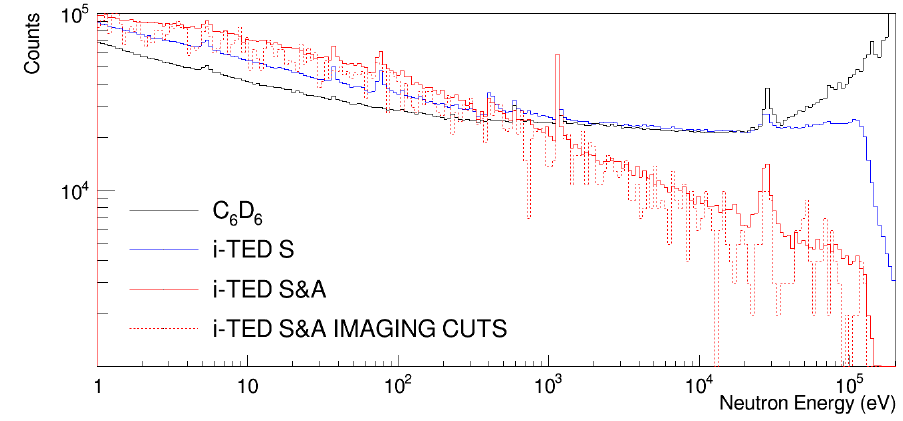
Figure 2. Neutron-energy spectra measured with the 56 Fe sample using the i-TED S-detector in singles-mode (blue line) and i-TED with S- and A-detectors in time-coincidence mode (solid red line). The spectrum measured with the C 6 D 6 detectors is shown in black. The dashed-red spectrum shows the best result obtained after a Compton imaging